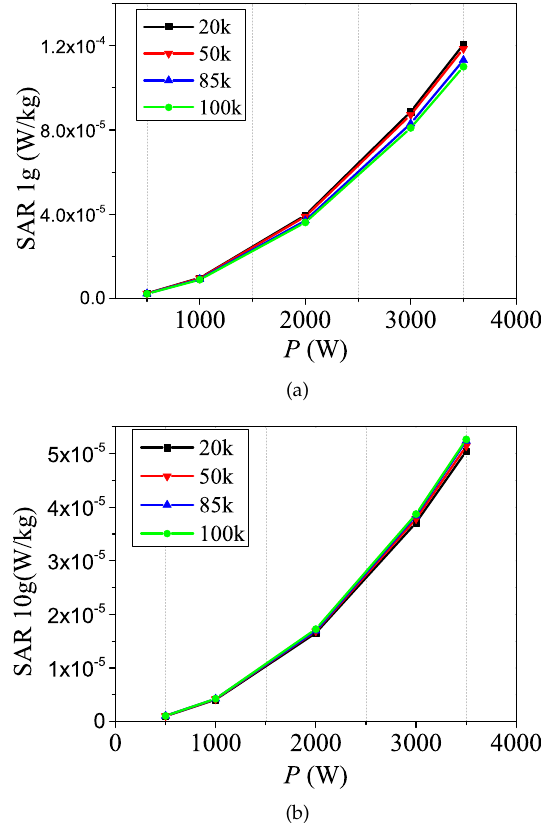
1g value and ( b ) SAR 10g value of the human body versus output − −